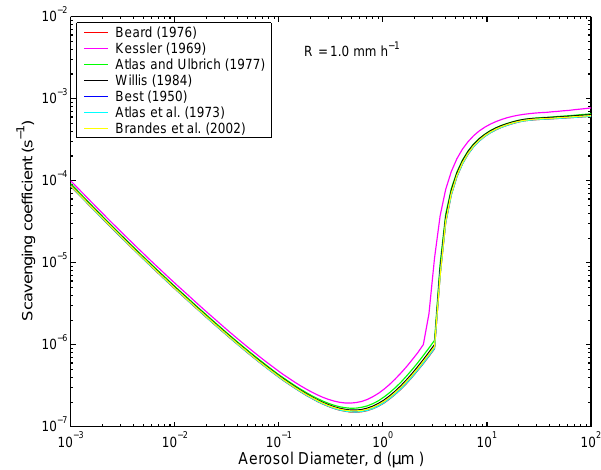
Fig. 7. Size-resolved scavenging coefficients as a function of par- ticle size for seven different terminal velocity parameterizations as- suming a rainfall intensity of 1.0mmh − 1